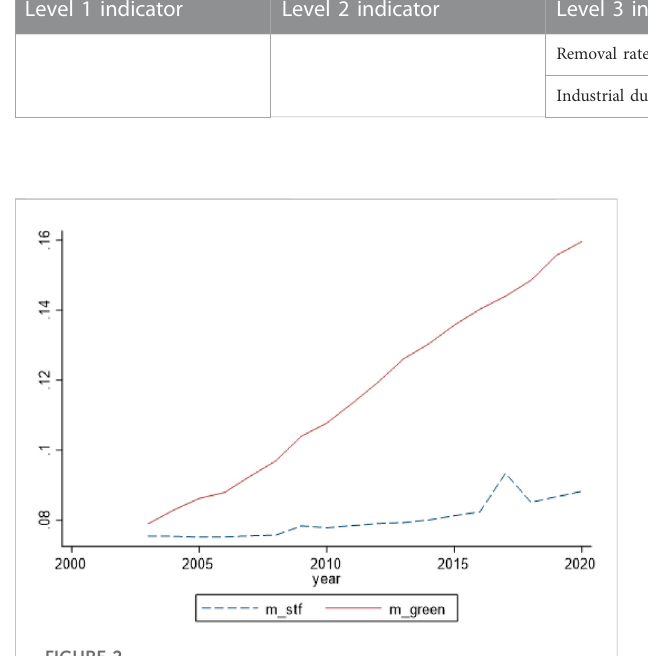
FIGURE 2 Brokenlinechartofaveragecomprehensiveindexofscienceand technology fi nance and green development from 2003 to 2020.